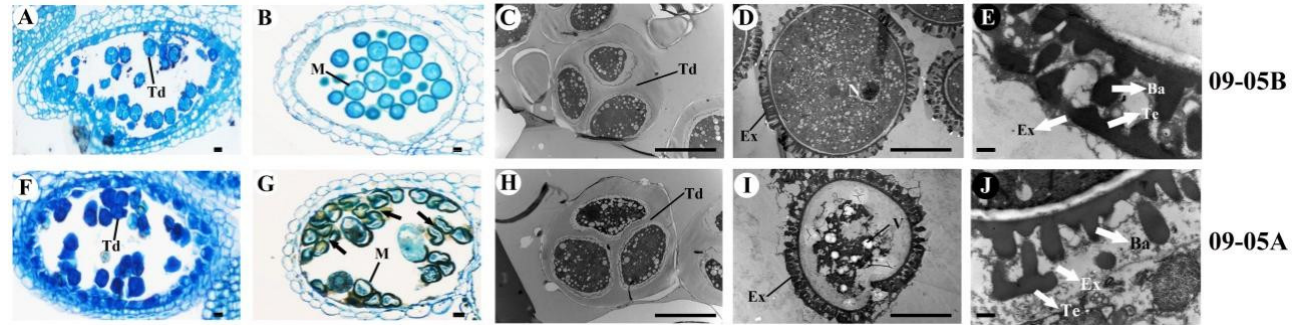
Figure 2. The cross-section analysis observation of anthers and microspores at the TE and BI stages of B. juncea from 09-05B and 09-05A. ( A , F ) Semi-thin section of anthers at the TE stage; ( B , G ) semi-thin section of anthers at the BI stage; ( C , H ) TEM micrographs of microspores at the TE stage; ( D , I ) TEM micrographs of microspores at the BI stage; ( E , J ) TEM micrographs of pollen exine at the BI stage. Ba—baculum; Ex—exine; M—microspore; N—nucleus; Td—tetrad; Te—tectum; V—vacuole. Arrows in ( G ) showed the remnants of the aborted microspores. ( A ,B,C, D , F ,G,H, I ) Bars = 10 μm; ( E , J ) Bars = 0.5 μm.